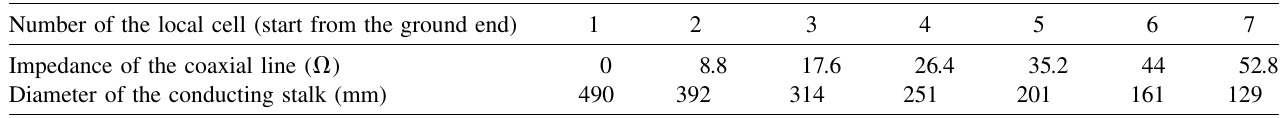
TABLE II. Size of the cathode stalk and corresponding impedance of the coaxial line.